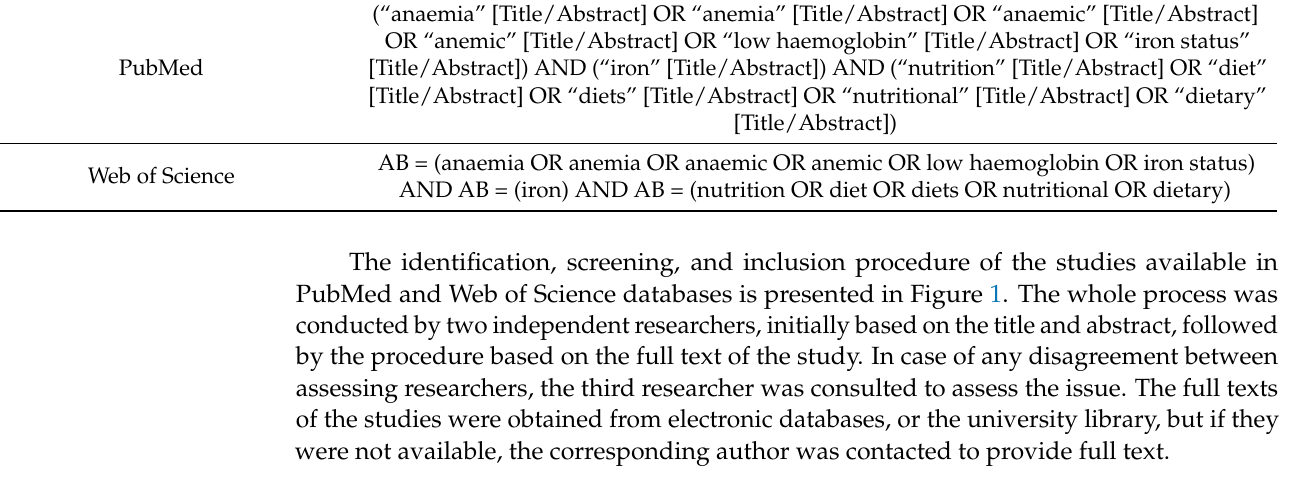
Table 2. The strategy of the electronic searching within PubMed and Web of Science databases. Database The Detailed Strategy of the Electronic